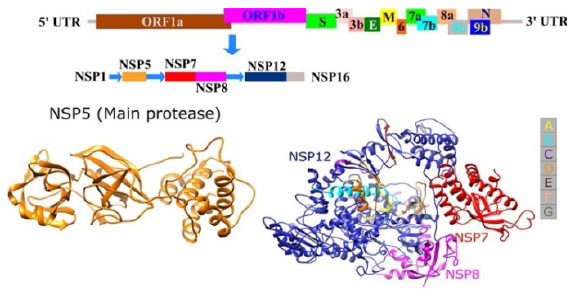
Figure 3. The SARS CoV2 RNA sequence, showing aschematic representation and the PDB structures of the main protease (Mpro) and RdRp [51]. Permission and copyright © 2021 American Chemical